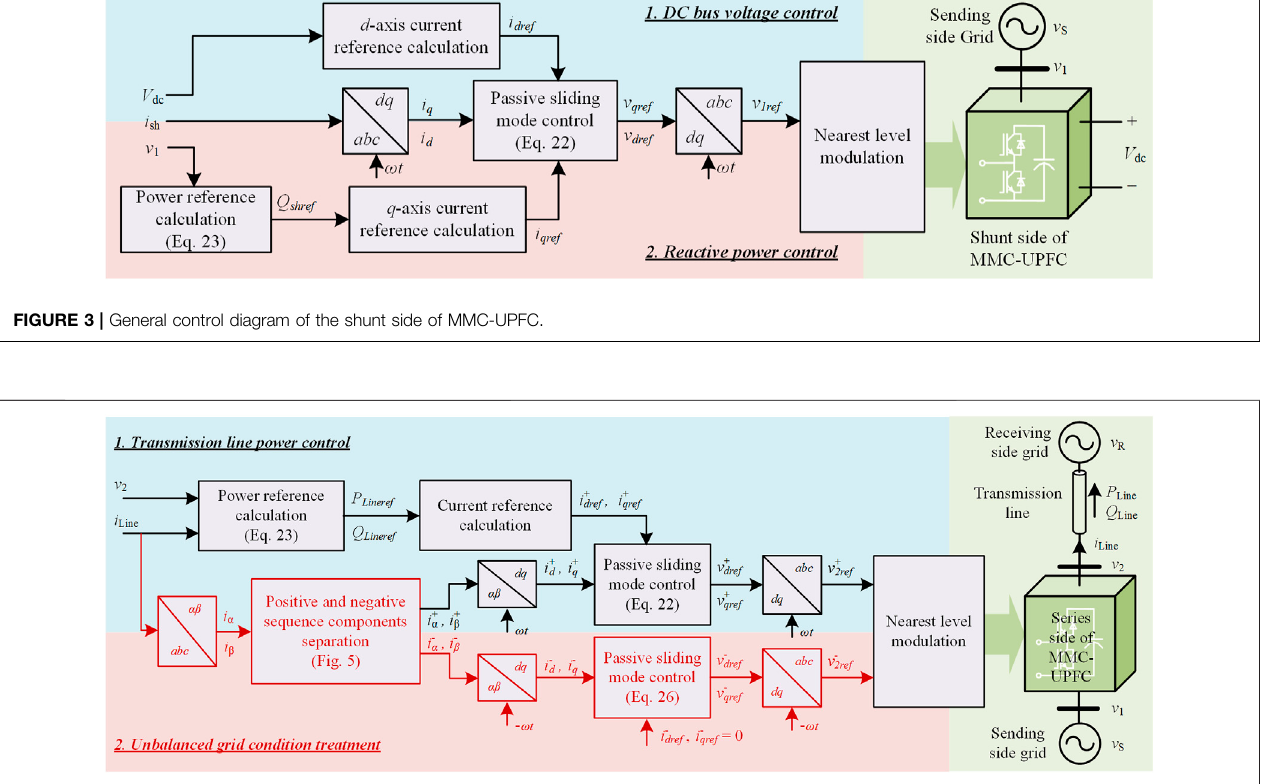
FIGURE 4 | General control diagram of the series side of MMC-UPFC with unbalanced grid condition treatment